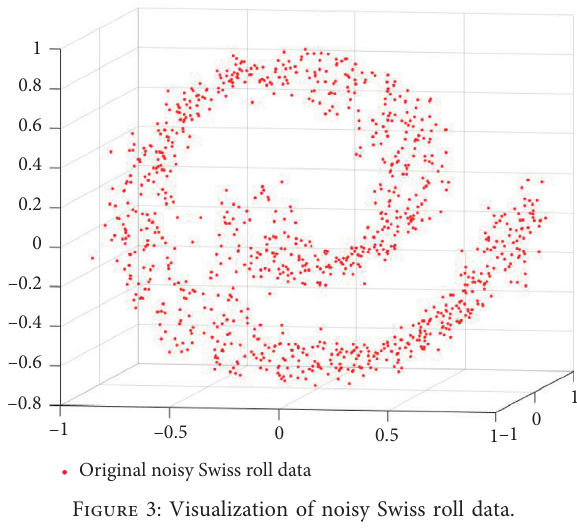
Figure 3: Visualization of noisy Swiss roll data.